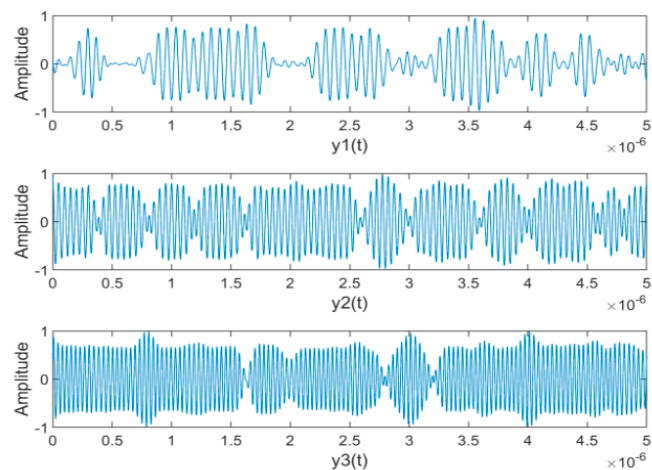
Figure 10. The waveforms of mixed signals.